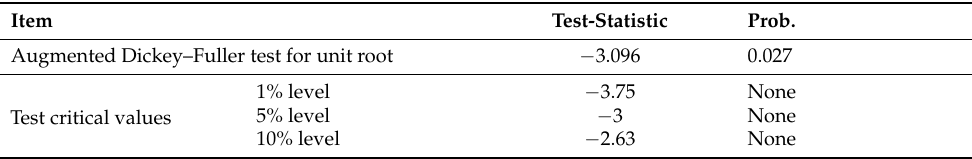
Table 7. Unit root test for the residual